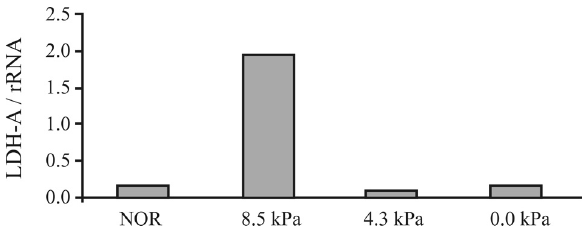
Figure 3 - Expression of LDH-A in the muscle of juvenile Astronotus crassipinis exposedtonormoxia,hypoxia(17kPaand0.9kPa)andanoxia for 8